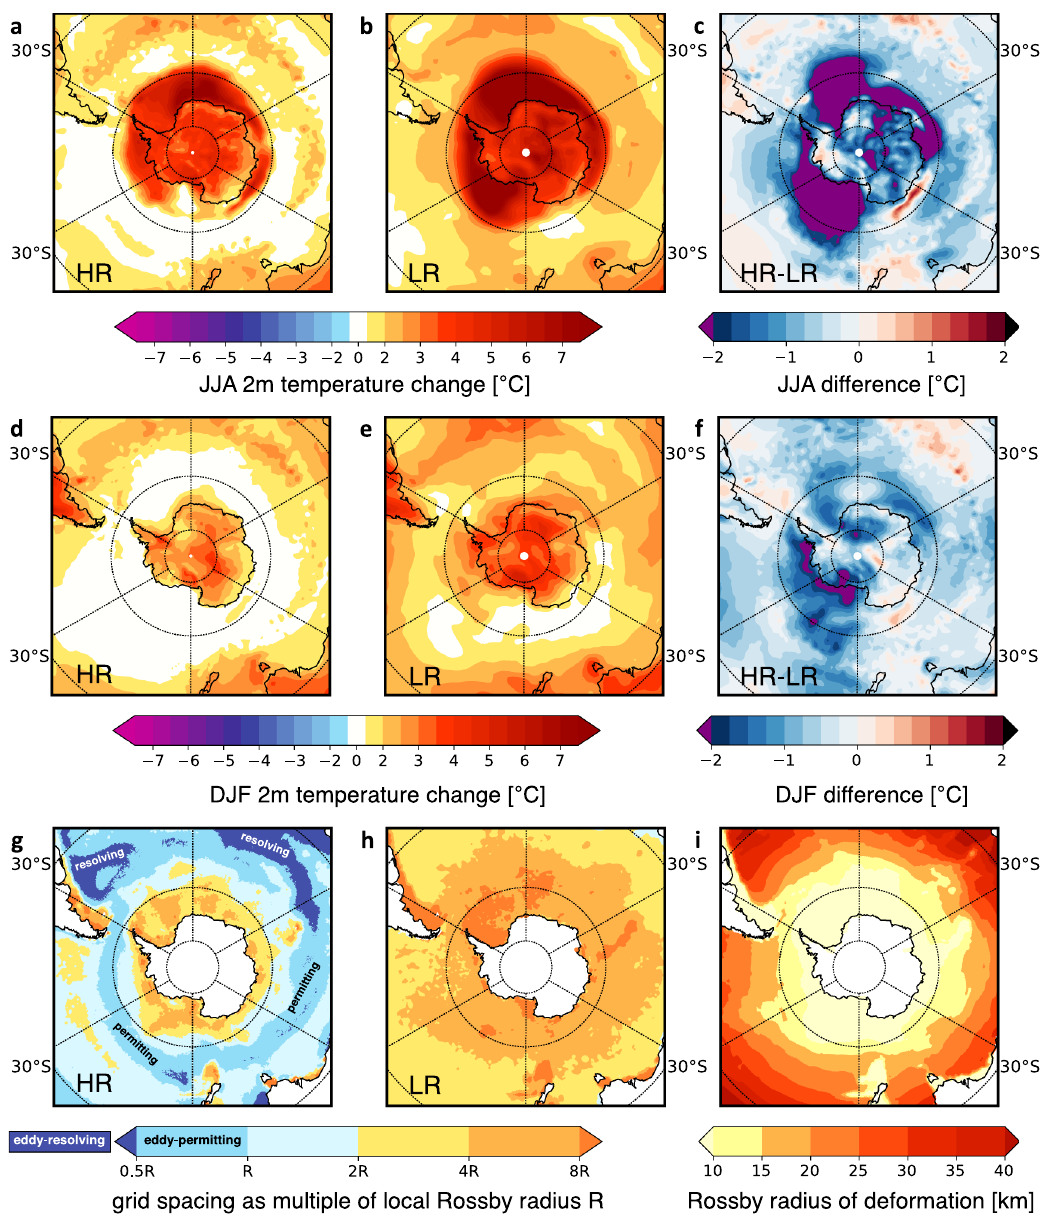
Fig. 2 Projected 2m temperature changes for the end of the twenty- fi rst century (2070 – 2099, relative to 1990 – 2019) in the JJA (June – July – August) and DJF (December – January – February) seasons. The projections with the a , d high-resolution (HR) and b , e low-resolution (LR) model con fi gurations are based on a Representative high-emission Concentration Pathway (RCP8.5 scenario). Differences in the climate response for c , f the HR and LR projections (HR-LR) are most pronounced in the Southern Hemisphere. A “ delta approach ” , as outlined by the HighResMIP protocol (High-Resolution Model Intercomparison Project, see “ Methods ” ), has been applied to isolate the climate change signal. The ocean grid spacing for g HR and h LR is given as a multiple of the local i , Rossby radius R of deformation ( “ Methods ”